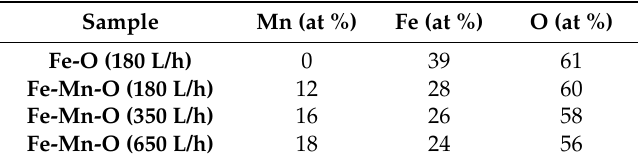
Table 2. Energy dispersive X-ray (EDX) composition of the foams produced from the Fe-containing slurry at a N 2 flow of 180 L/h and from the FeMn-containing slurry at a N 2 flow of 180, 350 and 650